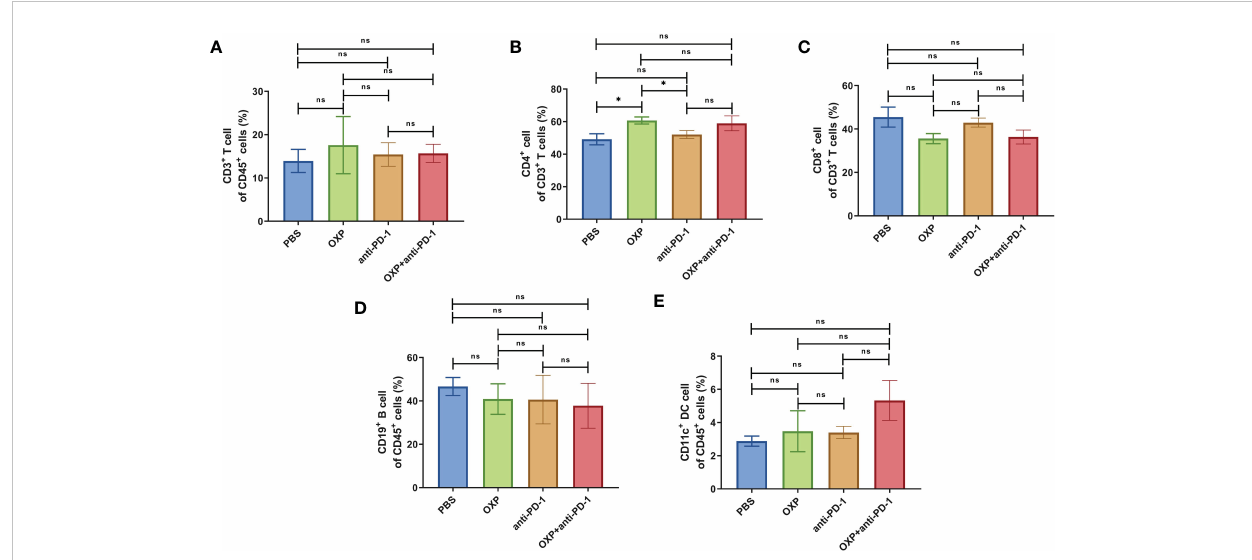
FIGURE 7 The composition of major immune cells populations in PBMC. (n = 3). (A) The percentage of CD3 + T cells of CD45 + cells. (B) The percentage of CD4 + T cells of CD3 + T cells. (C) The percentage of CD8 + T cells of CD3 + T cells. (D) The percentage of CD19 + B cells of CD45 + cells. (E) The percentage of CD11c + DC cells of CD45 + cells. ns P > 0.05, *P <